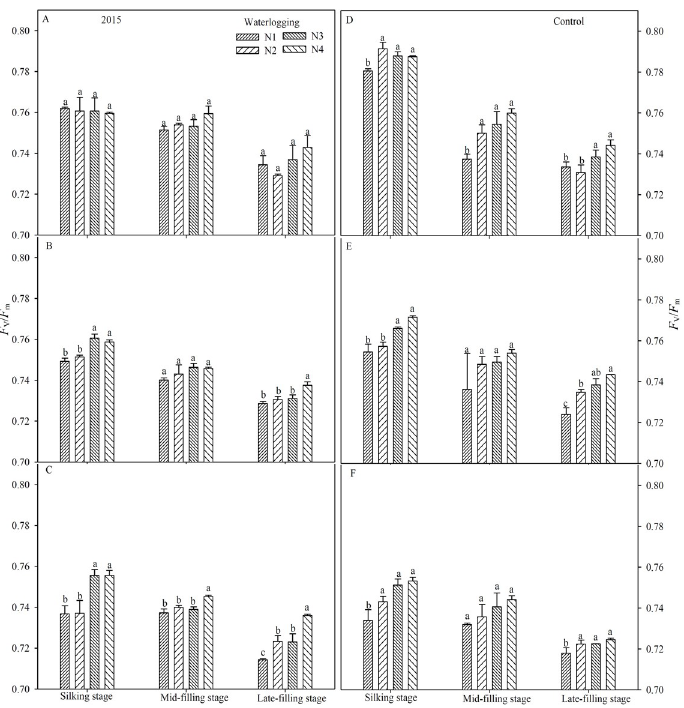
Fig 4. Maximal efficiency of PSII ( F v / F m ) in different leaf layers under different N treatments (2015). The error bars represent the standard errors of the mean. Different letters above the bars indicate significant differences ( p < 0.05) among the different N treatments. A,D: above-ear leaves; B,E: ear leaves; C,F: below-ear leaves. N1: 100% N applied as basal fertilizer, N2: 70% N applied as basal fertilizer and 30% N applied at the jointing stage, N3: 50% N applied as basal fertilizer and 50% N applied at the jointing stage, N4: 30% N applied as basal fertilizer, 50% N applied at the jointing stage and 20% N applied at the big flare stage.